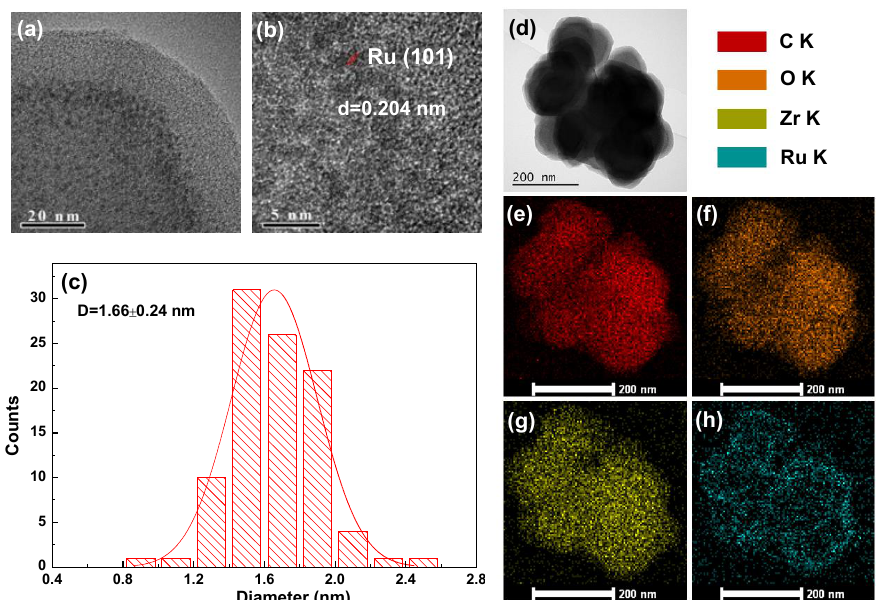
Figure 6. ( a , b ) The HRTEM images of Ru@UiO-66. ( c ) The size distribution histogram of Ru NPs. ( d – h ) The mapping of C, O, Zr, Ru elements on Ru@UiO-66 catalyst. Figure 7 gives the nitrogen adsorption-desorption isotherms and the classical